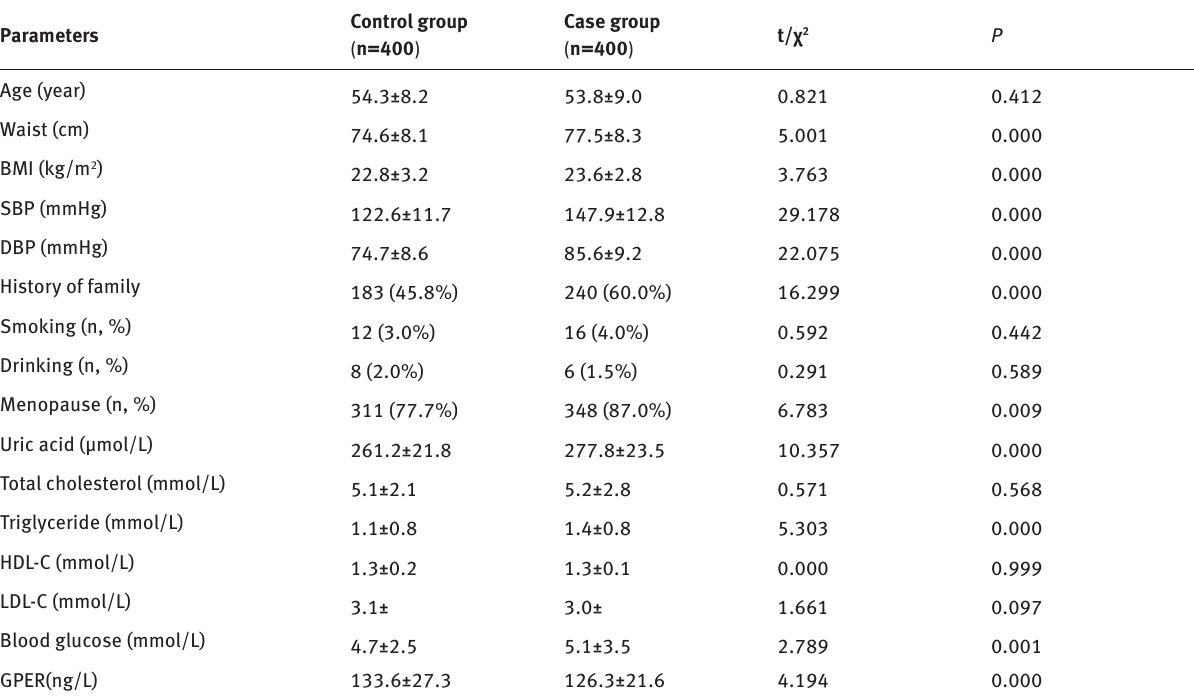
Table 1: Comparisons of general characteristics between case and control group